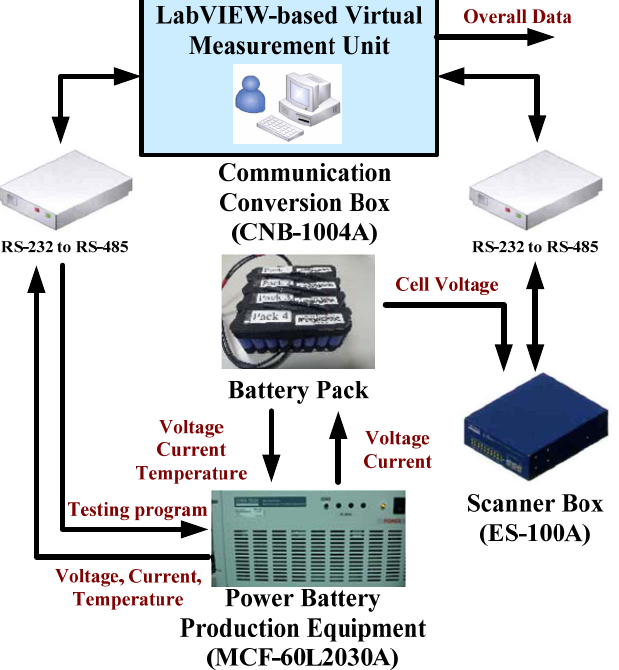
Figure 5. Schematic diagram of the battery pack test